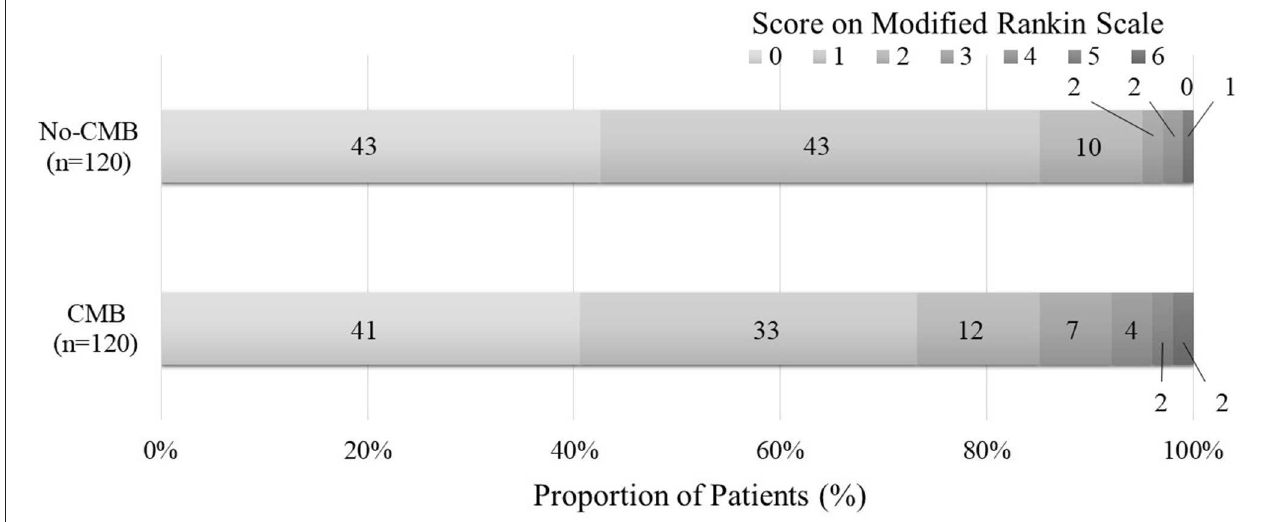
FIGURE 3 | Functional outcomes at 90 days as a function of modified Rankin scale scores. The percentages of patients with scores from 0 to 6 on the modified Rankin scale (mRS) in the CMB and no-CMB groups are shown as follows: 0, no symptoms; 1, no clinically significant disability; 2, slight disability (able to handle own affairs without assistance but unable to carry out all previous activities); 3, moderate disability (requiring some help but able to walk unassisted); 4, moderately severe disability (unable to attend bodily needs and unable to walk); 5, severe disability (requiring constant nursing care and attention); and 6, death. In the no-CMB group, no patient had a score of 5. In our analysis, there was no significant difference between the CMB group and the no-CMB group in the overall distribution of scores ( P = 0.195).